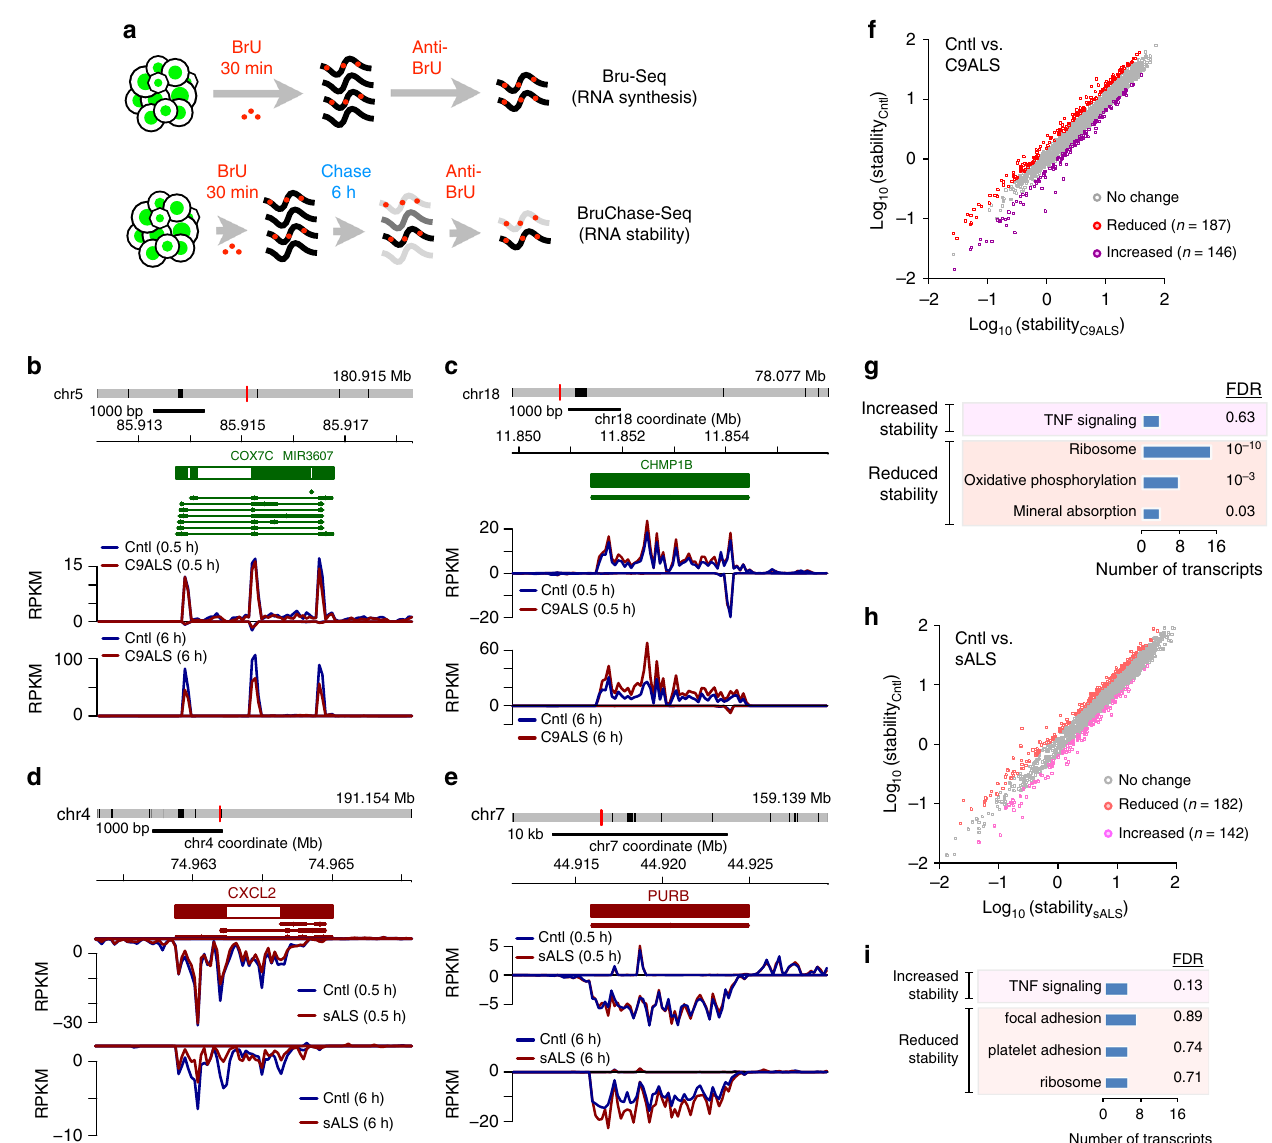
Fig. 1 RNA destabilization in ALS fi broblasts. a Schematic of Bru-seq (top) and BruChase-seq (bottom). BrU Bromouridine, Anti-BrU antibodies that recognize BrU. Example traces of RNA transcripts destabilized ( b ) or stabilized ( c ) in C9ALS fi broblasts. Blocks and lines denote gene and transcript structure, respectively. + strand genes are in green, – strand genes are in red. The traces represent RNA abundance at 0.5 h (top) and at 6 h (bottom) following Bru labeling. RPKM reads/kilobase of transcript/million mapped reads. Representative examples of RNA transcripts destabilized ( d ) or stabilized ( e ) in sALS fi broblasts. Scatter plot ( f ) and gene ontology ( g ) for 333 transcripts showing a change in stability ≥ 1.5-fold in C9ALS fi broblasts, in comparison to control (Cntl) cells. Stability is calculated as a ratio of transcript abundance at 6 h vs. 0.5 h. Scatter plot ( h ) and gene ontology ( i ) for 324 transcripts showing a change in stability ≥ 1.5-fold in sALS fi broblasts, compared to control cells. FDR false discovery rate. Cell lines used for these experiments